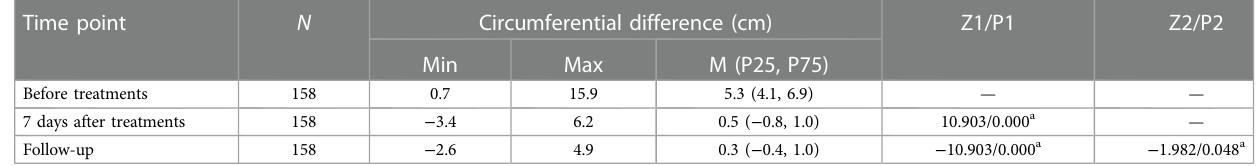
TABLE 2 Circumferential difference of bilateral arms before and after liposuction followed by lymphovenous anastomosis.